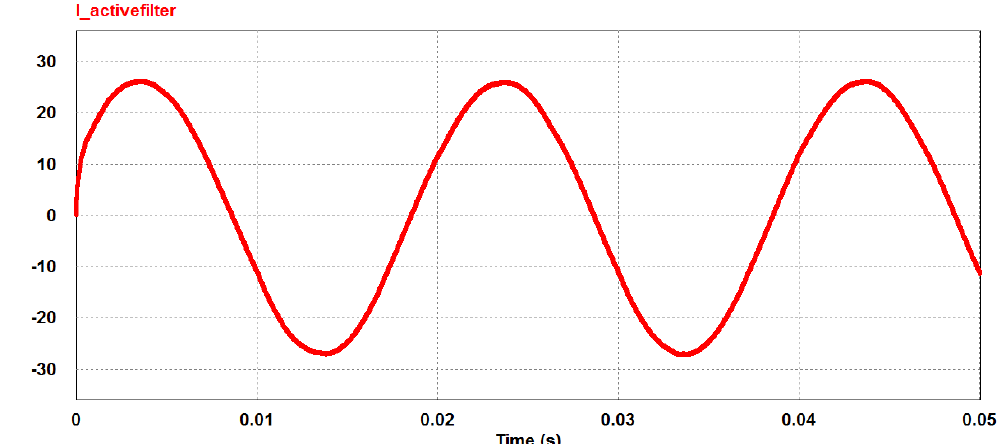
Figure 4(a). Input current waveform analysis of IHE after installation of